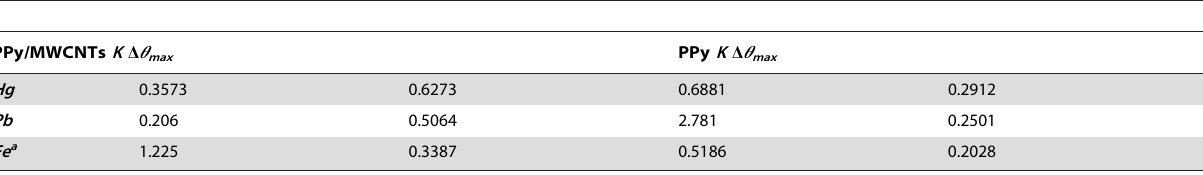
Table 2. Pertinent parameters of PPy and PPy-MWCNTs sensing layer were derived from Langmuire’s first order adsorption model.